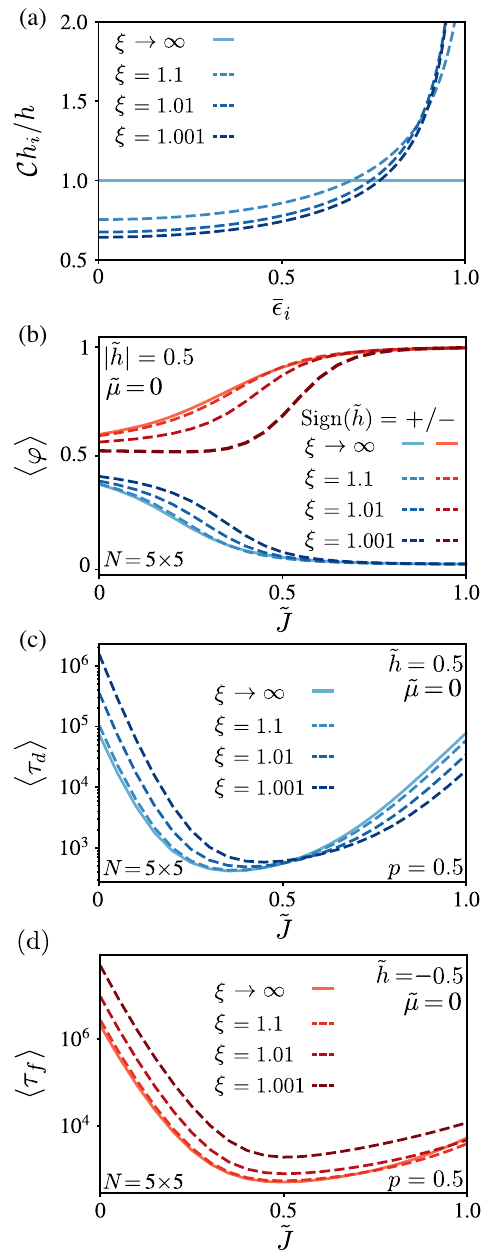
FIG. 14. Comparison between a uniform and nonuniform force load. (a) Nonuniform force load distribution given by Eq. (E3) as a function of the normalized lattice distance ¯ ϵ . For ξ < ∞ , i adhesion bonds located at the outer edge of the lattice are subject to a larger external force than adhesion bonds located at the inner part of the lattice. (b) Equation of state for a pulling (blue) and pushing (red) force for various values of ξ for a system of N ¼ 5 × 5 adhesion bonds with zero intrinsic binding affinity. (c,d) Mean first passage time to dissolution (c) and formation (d) for mixed Glauber-Kawasaki dynamics with constant Glauber at- tempt probability p ¼ 0 . 5 under a pulling (blue) and pushing (red) force for various values of ξ for a system of N ¼ 5 × 5 adhesion bonds with zero intrinsic binding